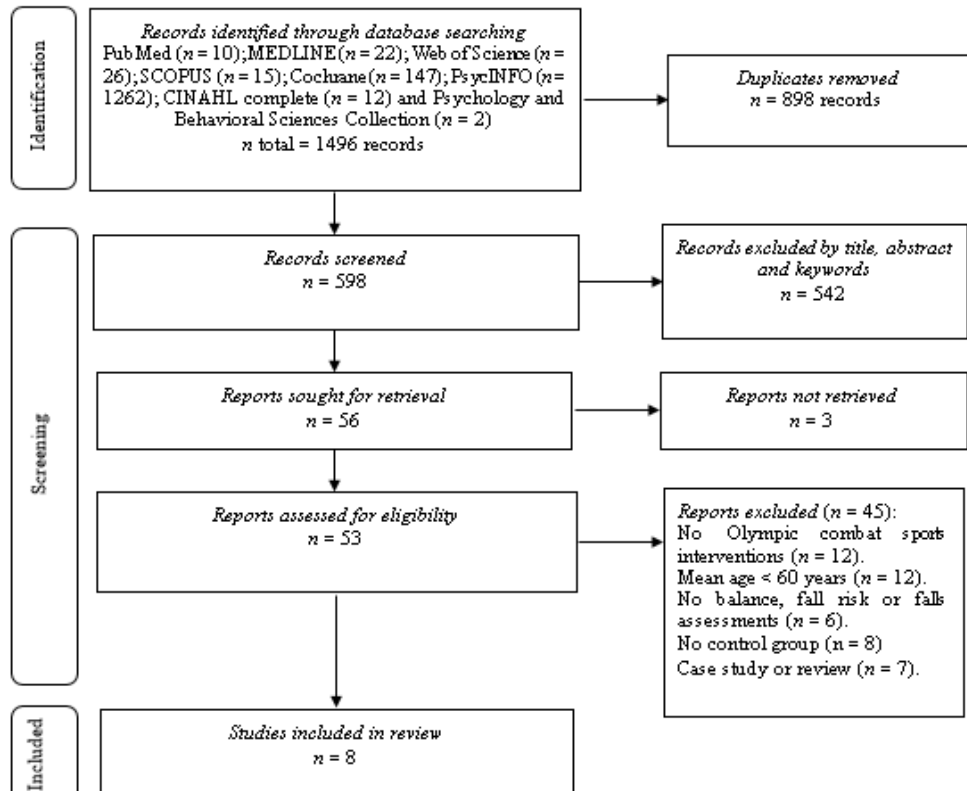
Figure 1. Flowchart of the review process. Legends: Based on PRISMA guidelines [23].